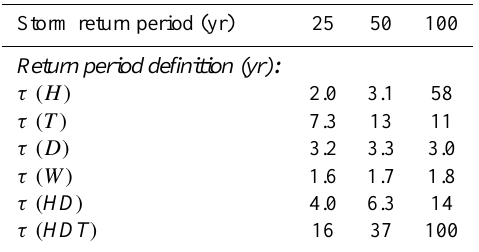
Table 4. The magnitude of different return periods (univariate, bi- variate, etc.) for the events listed in Table 3 which were selected to have multivariate return periods of 25, 50 and 100yr with matching associated erosion return